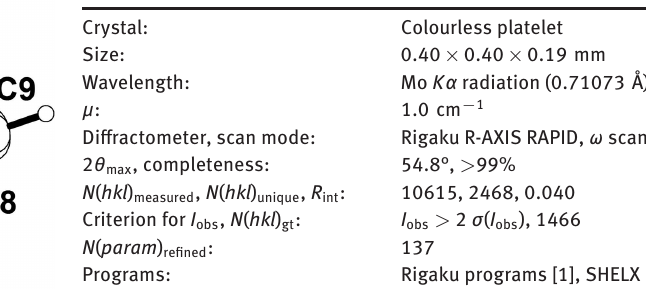
Table 1: Data collection and handling.